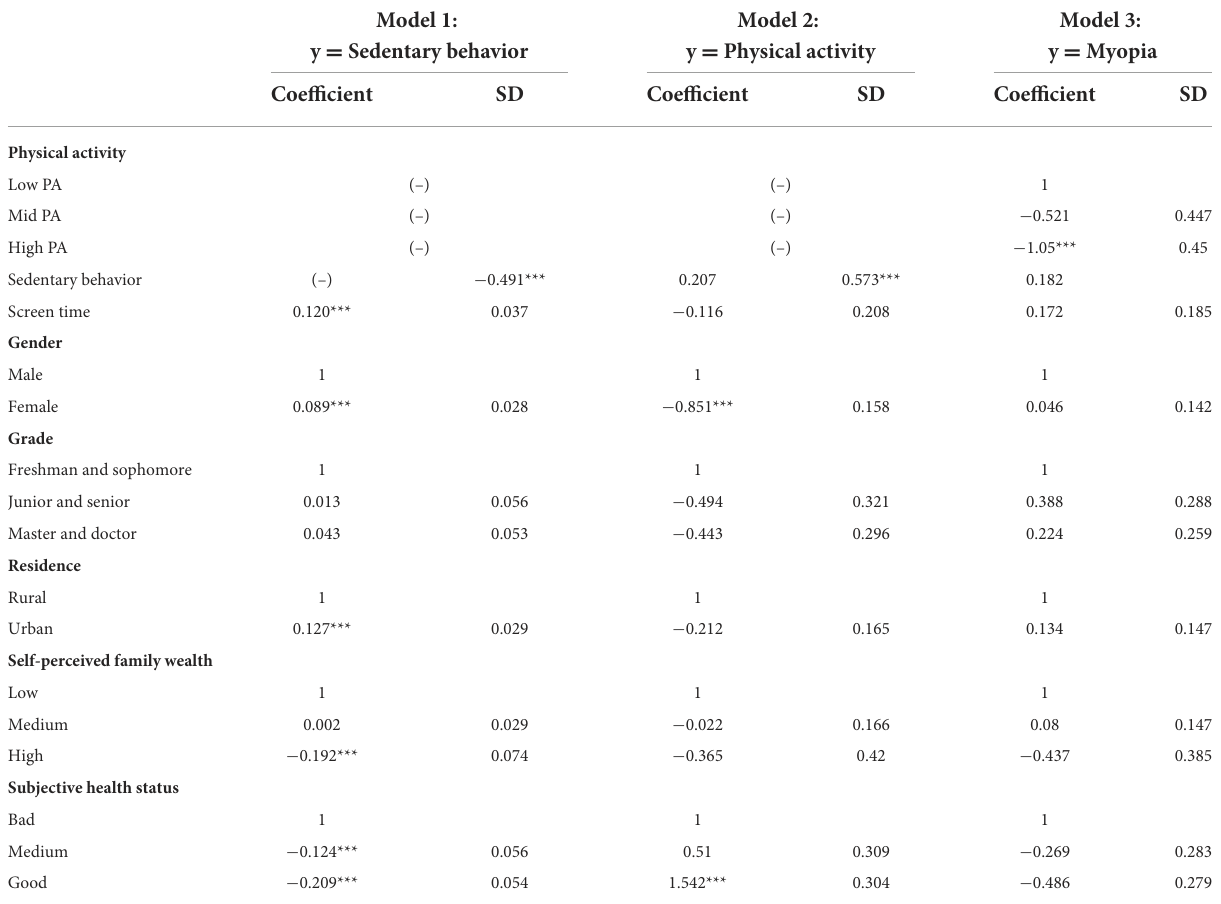
TABLE 2 Regression model results.